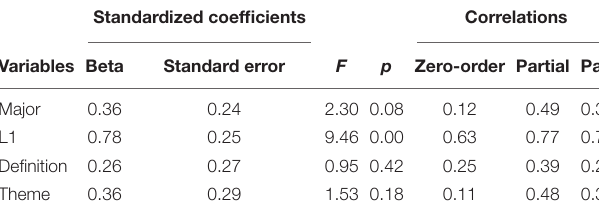
TABLE 8 | Categorical regression